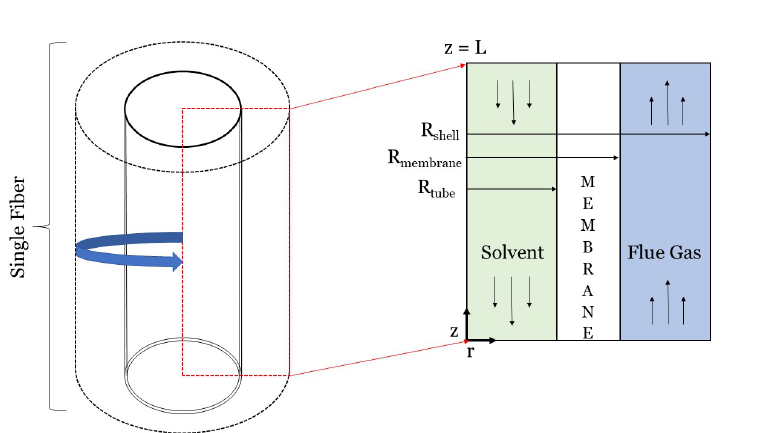
Figure 7. Graphic of the two-dimensional axisymmetrical modeling framework for a gas-liquid HFMC. The axial and radial dimensions are the dimensions of interest; variations in the angular dimension are not considered due to symmetry. In this graphic, solvent flows on the tube-side, while flue gas flows counter-flow on the